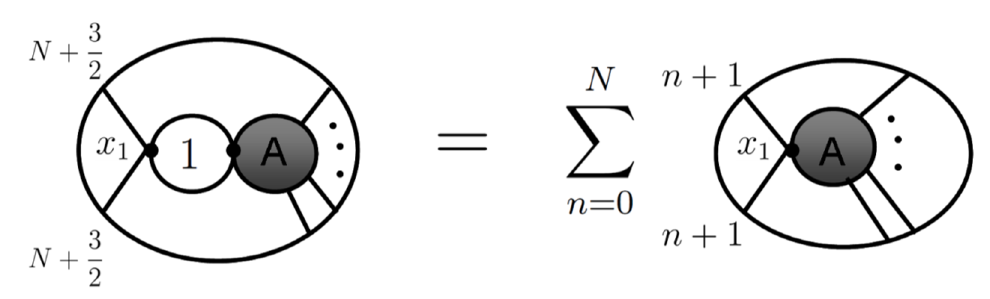
Figure 8 . Identity 6" gives a reduction of integer scaling dimension bubble diagrams, with half integer external legs. This identity is the 1-loop generalization of identity 3’ shown in (cid:12)gure 5. The grey blobs are general. We are suppressing numerical coe(cid:14)cients in these plots, and the diagrams correspond to stripped